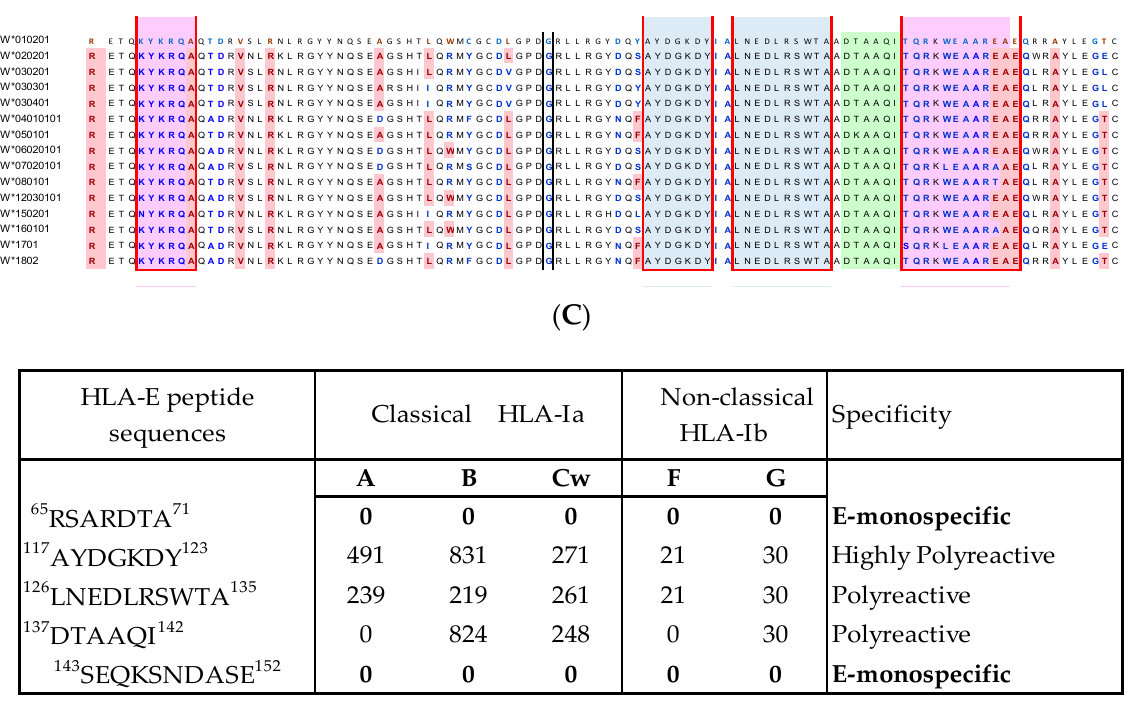
entation of the HLA-E mAb specific epitopes on the α 1 and α 2 helices of HLA-E. It is